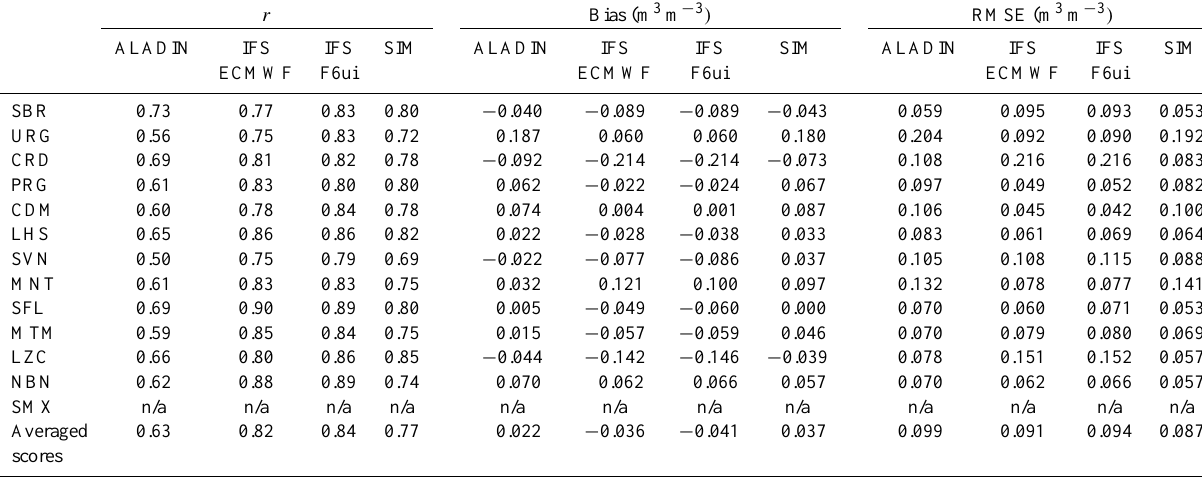
Table 5. Evaluation of operational surface soil moisture products from meteorological services using the SMOSMANIA surface soil moisture (5cm depth) over a one year period (July 2008–June 2009). The last row shows the average of the 12 stations.